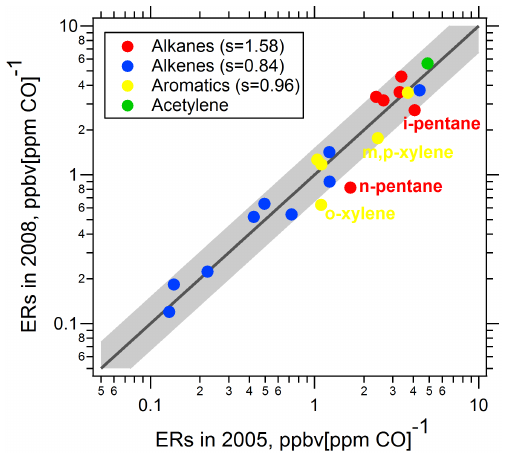
Figure 5. Comparison of the emission ratios (ERs) of NMHCs rel- ative to CO in the 2008 and 2005 summers at the PKU site, where each point represents one compound and different colors indicate the classes of NMHCs. The black line represents the 1:1 line and the shaded area shows the agreements within a factor of